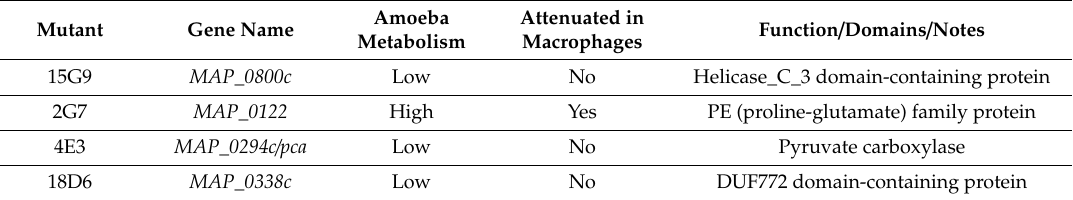
Figure 5. MAP transposon library screening for changes in amoeba metabolism. ( A ) Acanthamoeba castellanii monolayers seeded in 96-well plates were infected with the wild-type MAP or transposons mutants at MOI of 10:1 for 2 h. Extracellular bacteria were removed by washing cells with the Page’s amoeba saline, after which wells were replenished with 712 PYG media containing 10% ( v / v ) AlamarBlue dye. Fluorescent readings were recorded at 24 h of post-infection on a Tecan F200 plate reader. The dashed black line represents the metabolic activity of amoeba produced by the wild-type MAP infection. Mutants that displayed changes in amoeba metabolism by 2-times greater or less than the wild-type MAP are shown in red or blue bars, respectively. ( B ) The histogram demonstrates the distribution of MAP mutant library based on the fold-change in amoeba metabolism. Table 2. List of genes interrupted in MAP